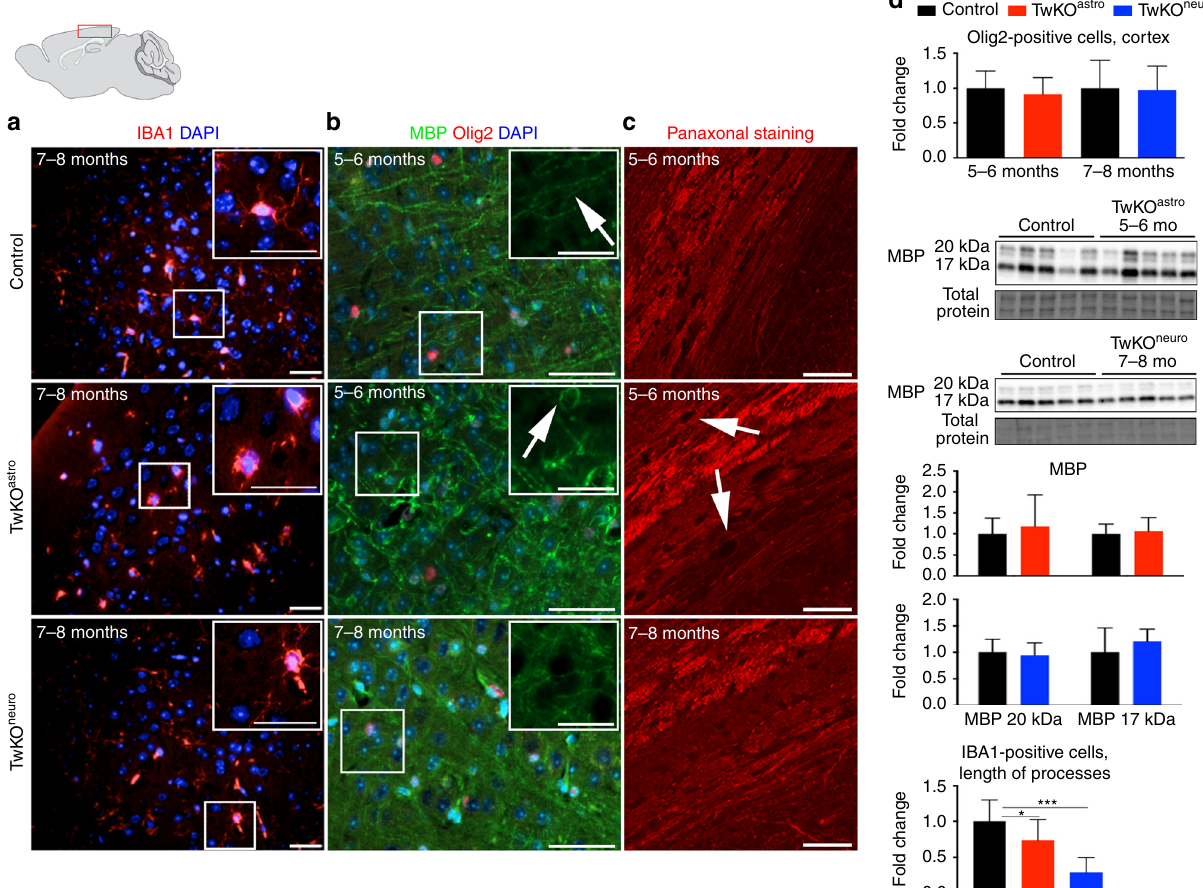
Fig. 7 Inactivation of Twinkle in astrocytes leads to microglial activation and demyelination. Immuno fl uorescent staining of mid-sagittal sections from 6 months old mice, brain graph shows sampling site. a Immuno fl uorescent staining of microglia (IBA1, red) and nucleus (DAPI, blue) in cortex. b Myelin content (MBP, green), oligodendrocytes (Olig2, red), and nuclei (DAPI, blue). c Pan-axonal staining of long axons in corpus callosum. d Quanti fi cation of Olig2-positive cells and length of processes of IBA1-positive cells in cortex; western blot of MBP, and its quanti fi cation. Insets: enlarged boxed area. Scale bars: 20 μ m ( a ), 50 μ m ( b , c ). The data are presented as mean and error bars indicate standard deviation. Statistical signi fi cance: * p < 0.05, *** p <